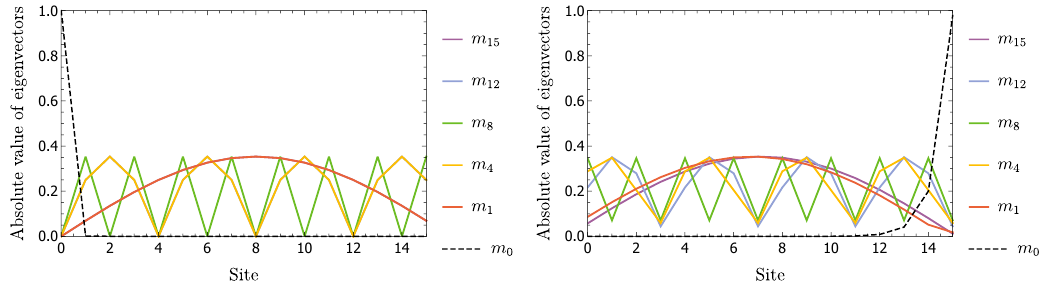
Figure 2 . Composition of the left-handed (left panel) and right-handed (right panel) mass eigen- modes in terms of the original clockwork (cid:12)elds in the uniform clockwork model with N = 15, m = v , q = 4 : 887, and y = 0 :